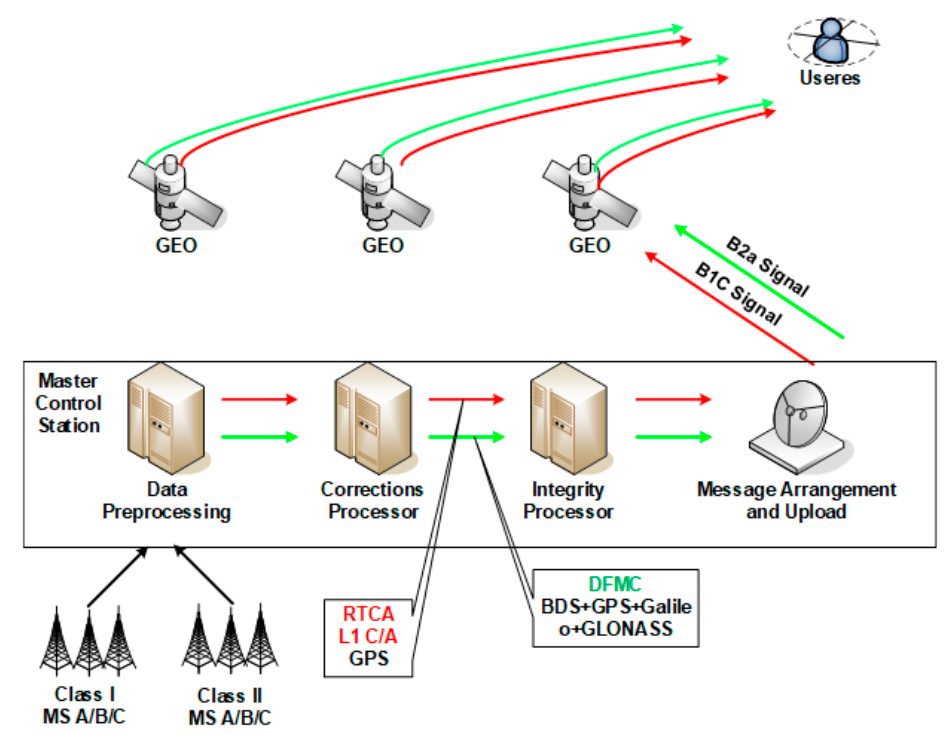
Figure 1. The workflow of the BDSBAS system. The red line indicates the SF service messages processing and the green line indicates the DFMC service messages processing.